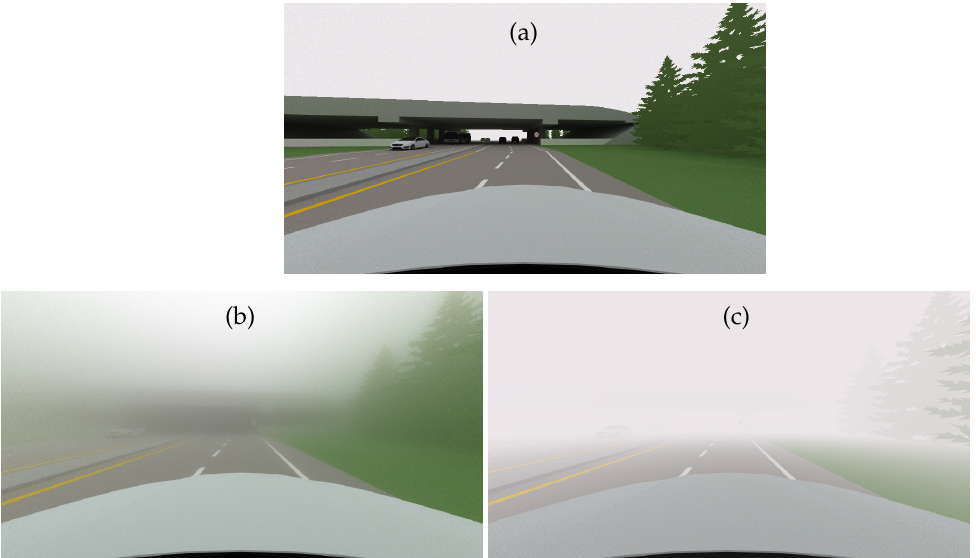
Figure 8. Simulated images for the extra-urban scene with the SWEET simulator without fog ( a ) and with fog (MOR = 20 m, ( b )) and with the Koschmieder model ( c ) in day conditions. Figure 9 gives the simulations of the extra-urban scene in night conditions.